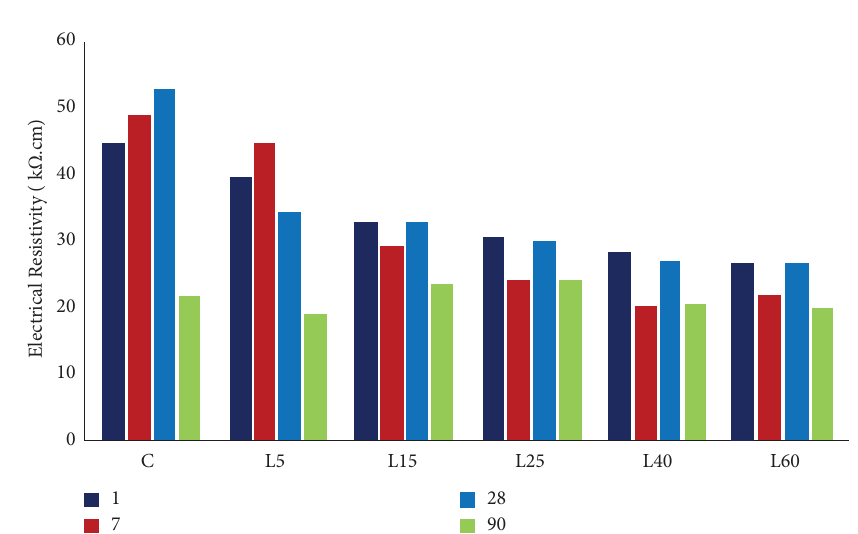
Figure 13: Electrical resistivity values of the limestone